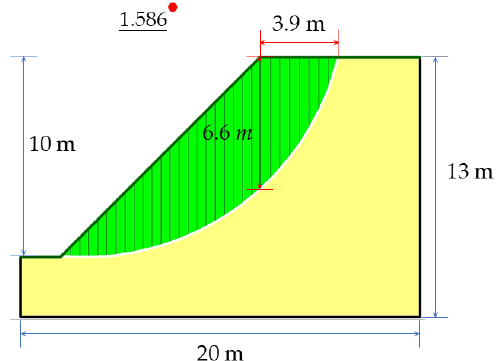
Figure 7. Critical slip surface calculated by the limit equilibrium method.